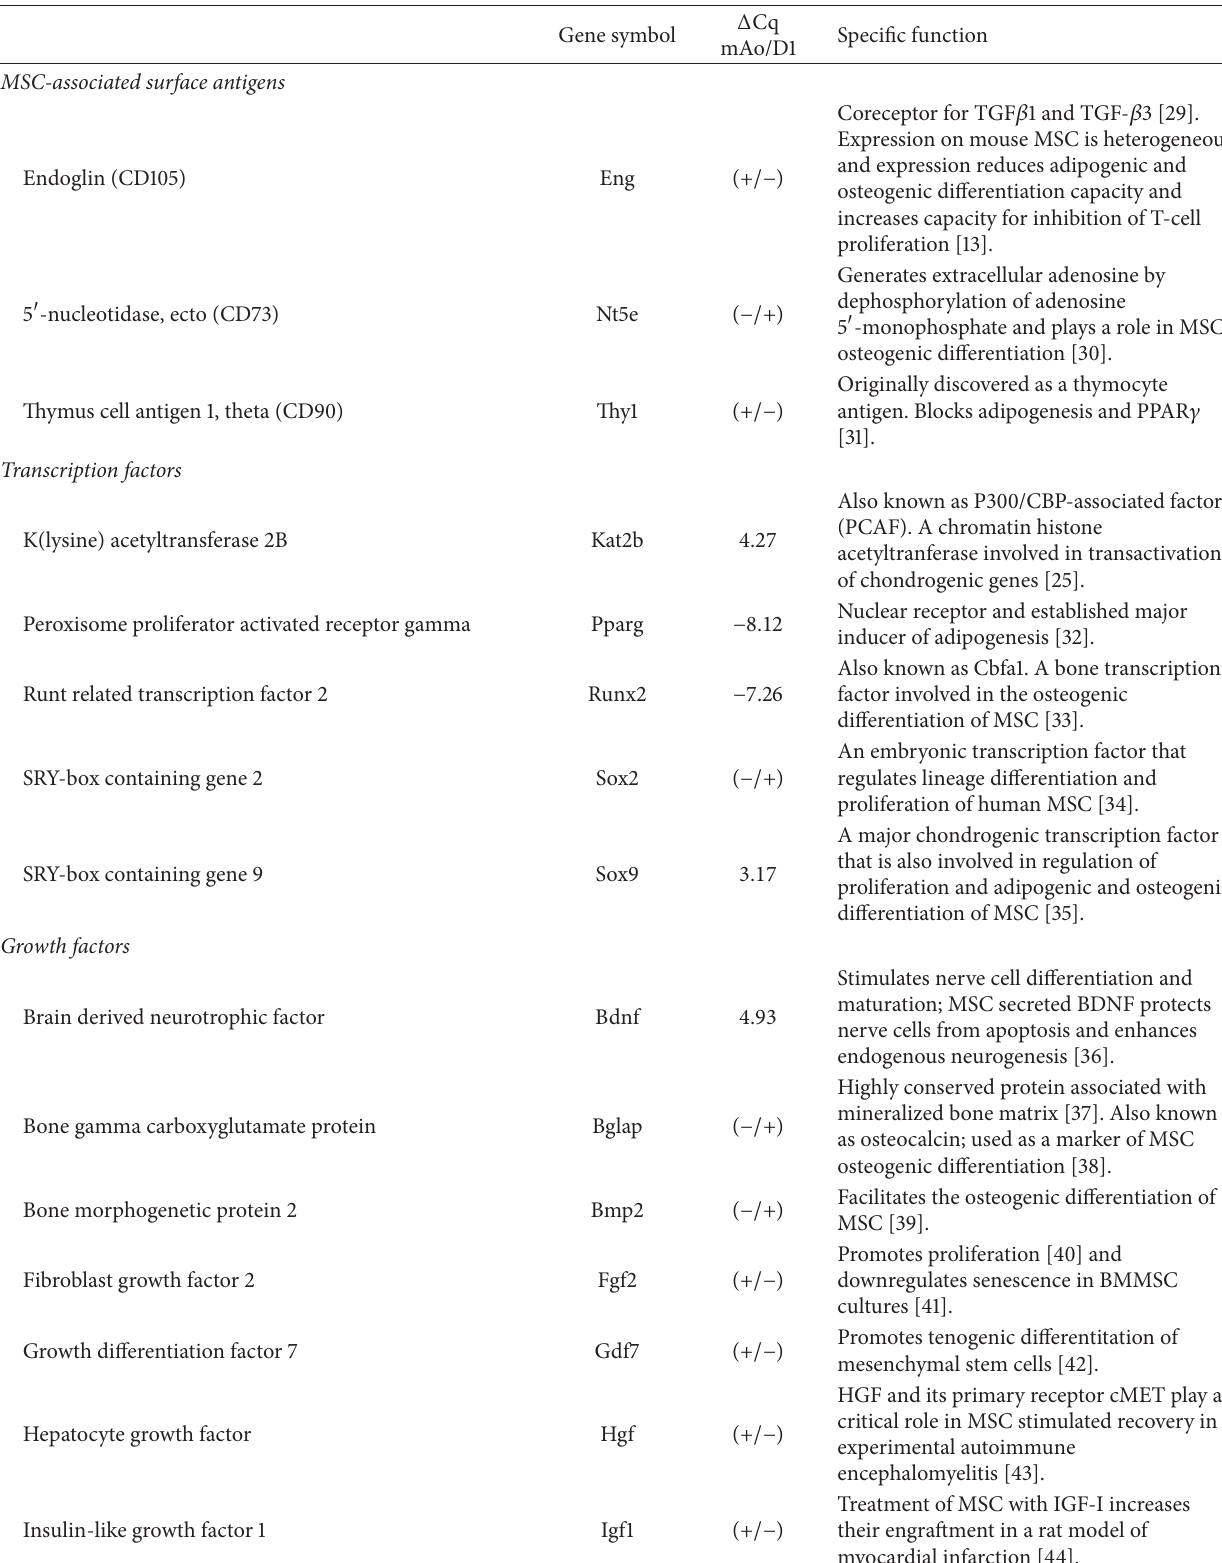
Table 1: Genes differentially expressed in mAo and D1 progenitor stem